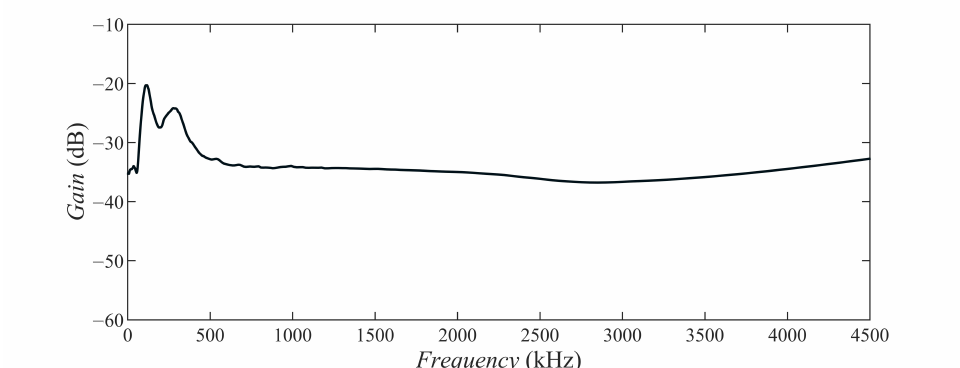
Figure 2. Response curves for